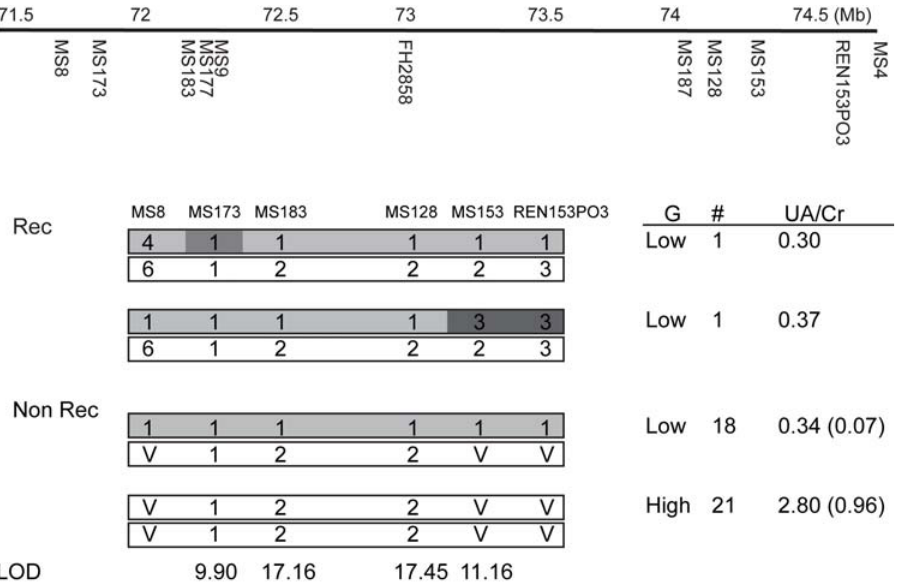
Figure 2. Fine structure mapping of the huu locus. (A) Physical map showing the location of the microsatellite markers used to map huu on CFA03. Microsatellite markers are listed below the line, and distances in Mb are shown above the line. (B) The haplotypes of recombinant (Rec) and non recombinant (Non Rec) backcross dogs are depicted with Dalmatian haplotypes in white and the Pointer haplotype in grey. A ‘‘V’’ indicates that the alleles were variable in Dalmatians. The first recombinant was not informative for MS173. The recombinants localized huu between MS8 and MS153. The maximum LOD score calculated for each microsatellite for all members of the family is shown at the bottom of the figure. The uric acid to creatinine ratio (UA/Cr), with the standard deviation in parenthesis, the number of dogs in each class ( # ), and the inferred huu genotype (G) are shown for dogs born since 2006 (28). The range of Uric acid/creatinine ratios for the low uric acid dogs is 0.23 to 0.47, and the range for high uric acid dogs is 1.2 to